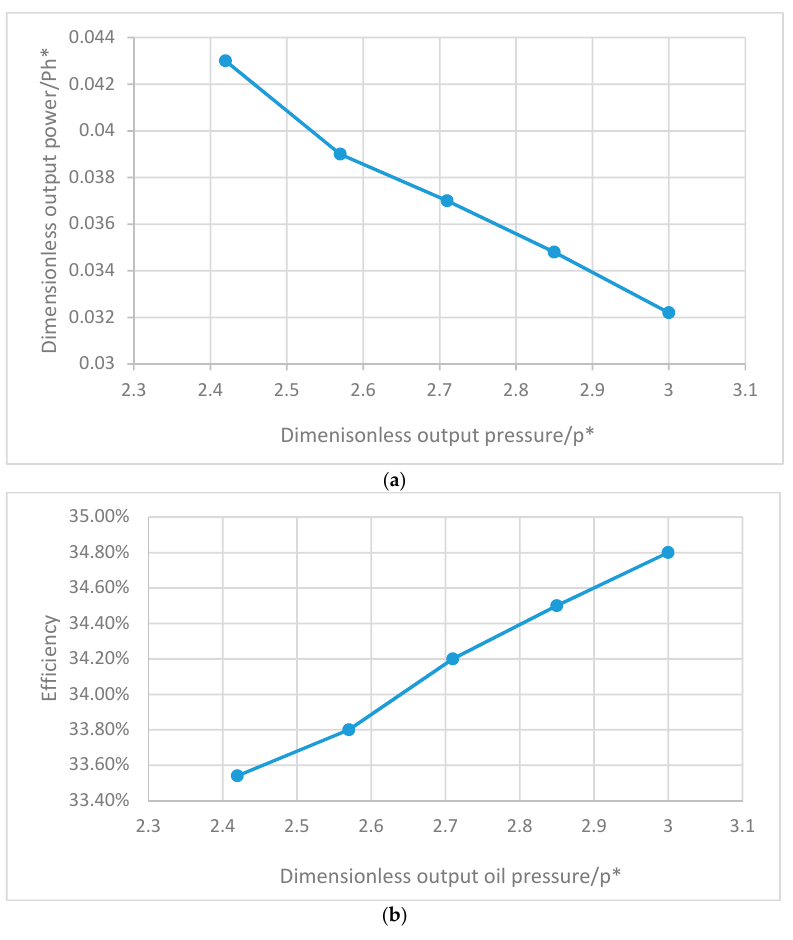
Figure 8. Relationships of the output power, efficiency and the output pressure. ( a ) Output power trend curve influenced by the output pressure; ( b ) Efficiency trend curve influenced by the output pressure.